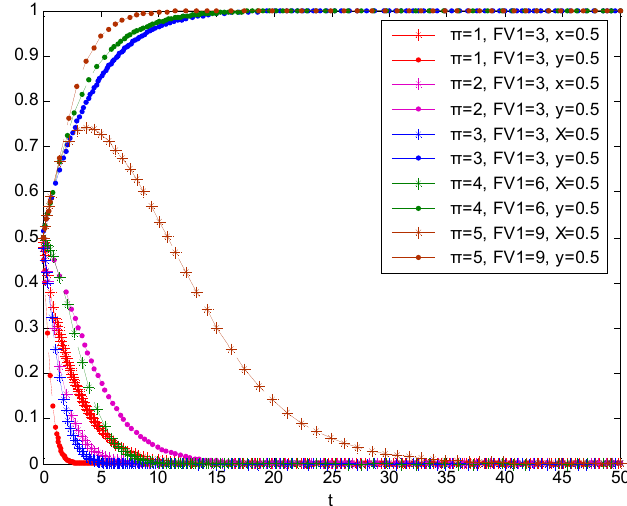
Figure 7. Simulation results of the evolutionary game between the two parties under the condition that power of the government and regulation is improved.